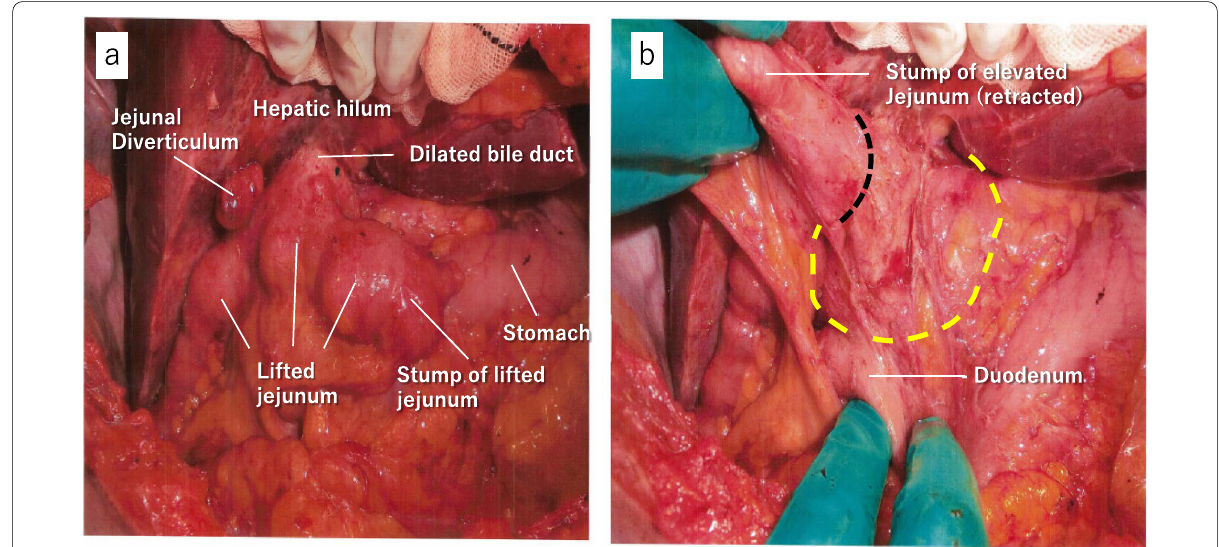
Fig. 3 Intraoperative photographs which prove that the previous surgery was IDS. a Lifted jejunum is anastomosed to the ventral side of dilated bile duct with side-to-side anastomosis. A jejunal diverticulum was seen (cholecystectomy had been performed with this patient). b Dilated bile duct and anastomosis are exposed after mobilization of the lifted jejunum. A yellow dotted line shows dilated bile duct. A black dotted line shows side-to-side anastomosis with lifted jejunum